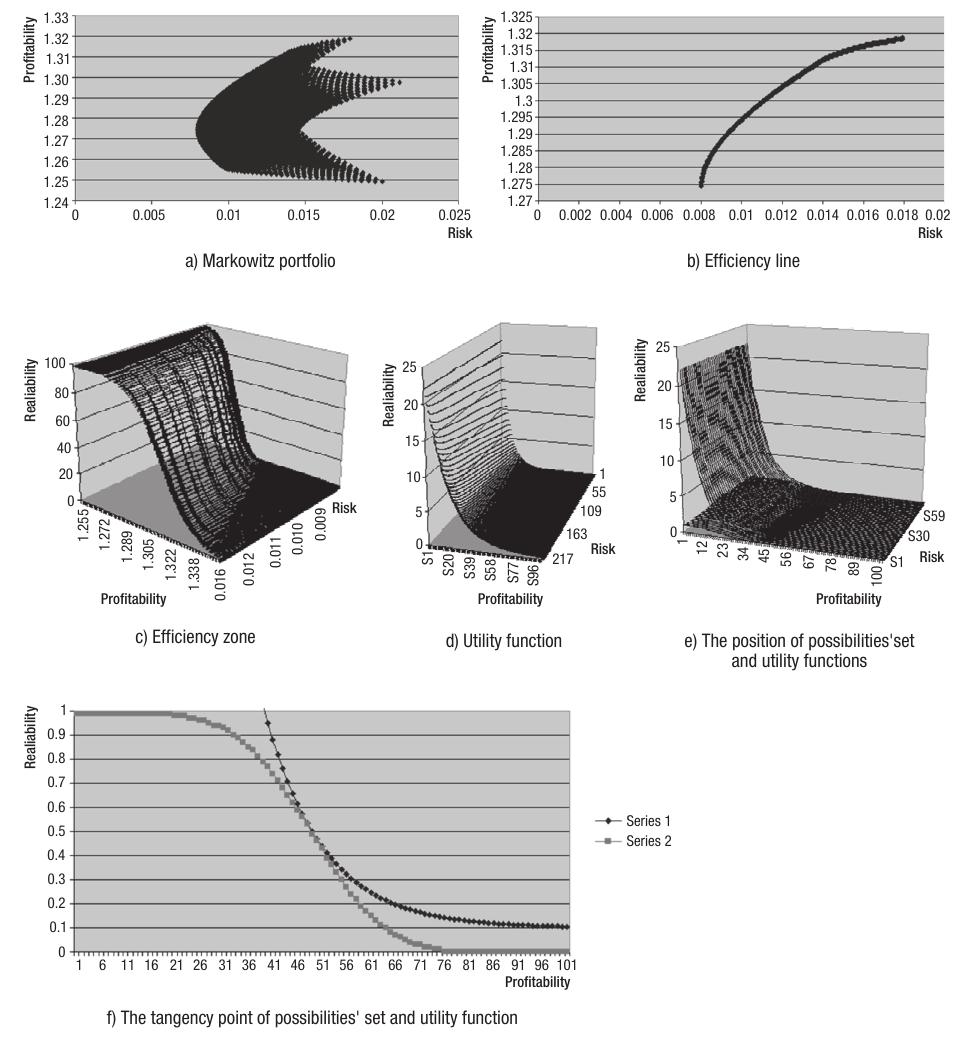
Fig. 8. Visualization of (4)–(6) problem solving, when the situation analogical to Fig. 5 is analysed, based on the structure a priori provided by